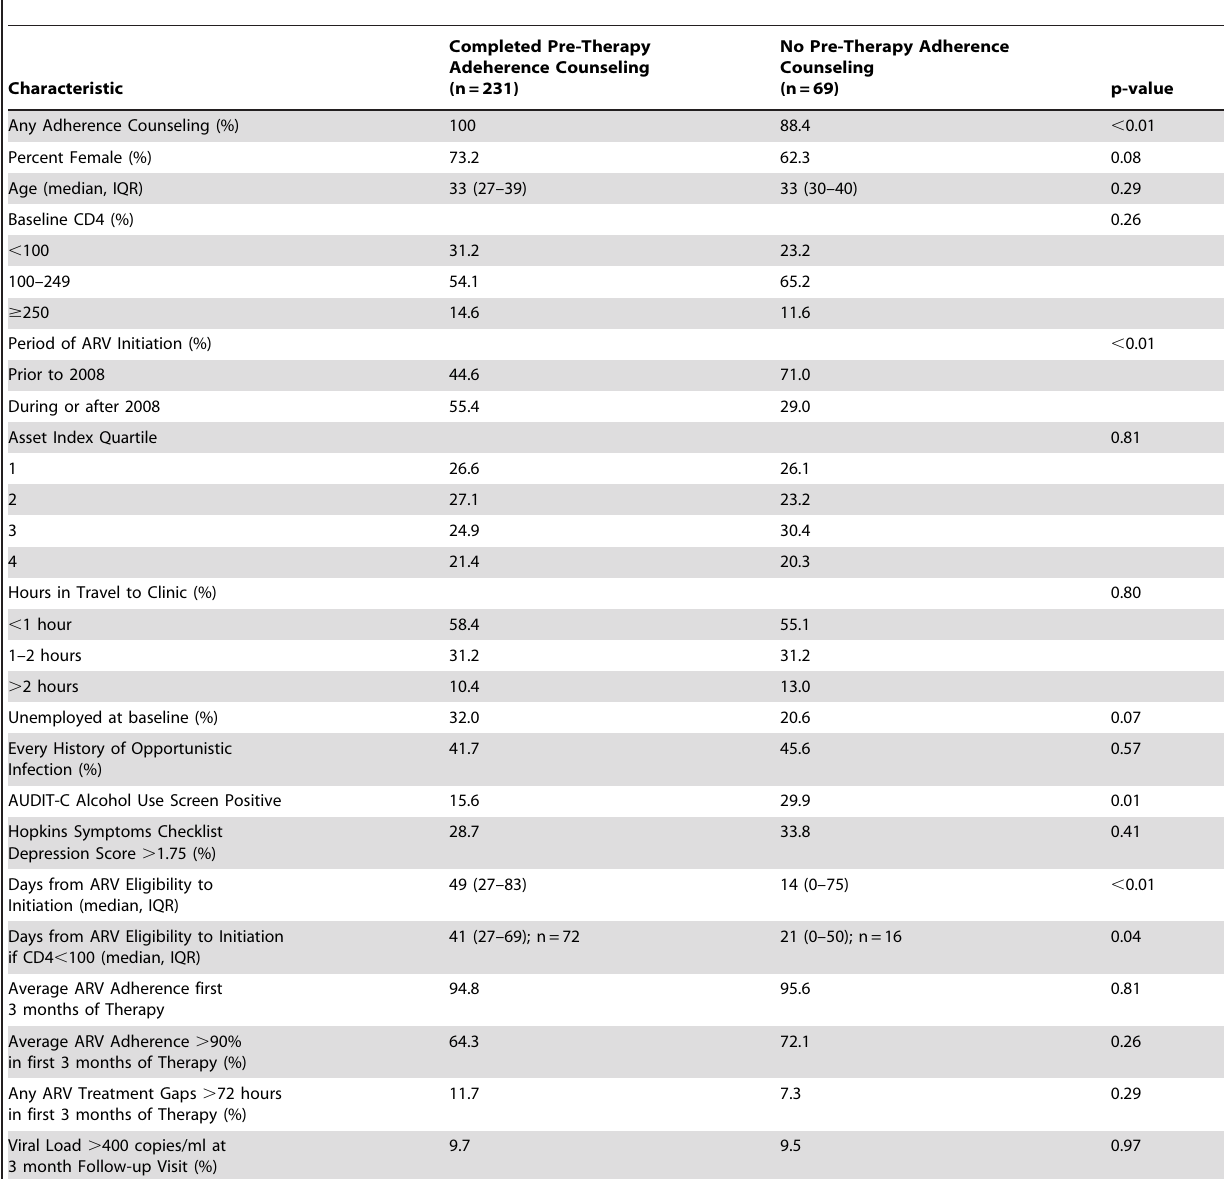
Table 1. Baseline demographic, socioeconomic and clinical characteristics in study cohort of patients initiating ARVs in rural